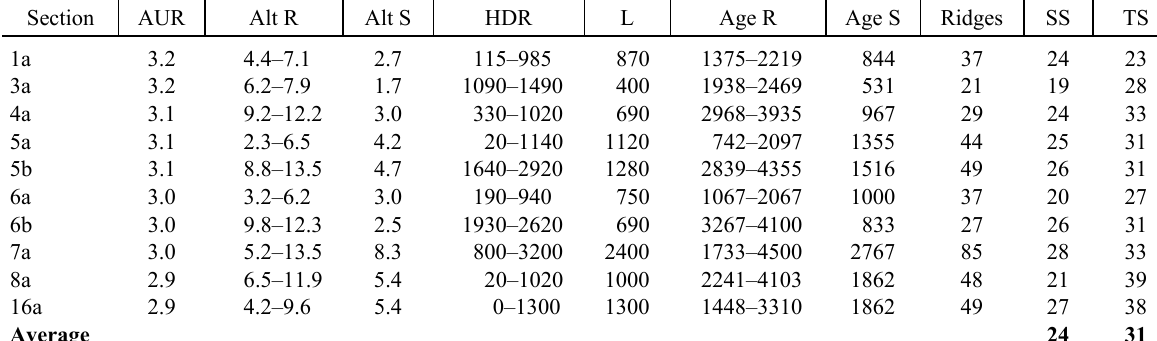
Table 2. Detailed description of the patterns along specific profile sections within the longer transects (shown in bold in Table 1). AUR, apparent uplift rate in the late Holocene (AUR = LU(G) – 0.2, mm/yr); Alt R, altitude range (m); Alt S, altitude span (m); HDR, horizontal distance range on the profile (m); L, length of the section (m); Age R, age range (cal yr BP – years before present; Age = altitude/AUR); Age S, age span (yr); SS, spatial spacing, metres per ridges (SS = L/ridges); TS, time spacing, years per ridges (TS = Age R/ridges). Note that the cyclicity estimation (TS) is based on relative age differences (age spans),